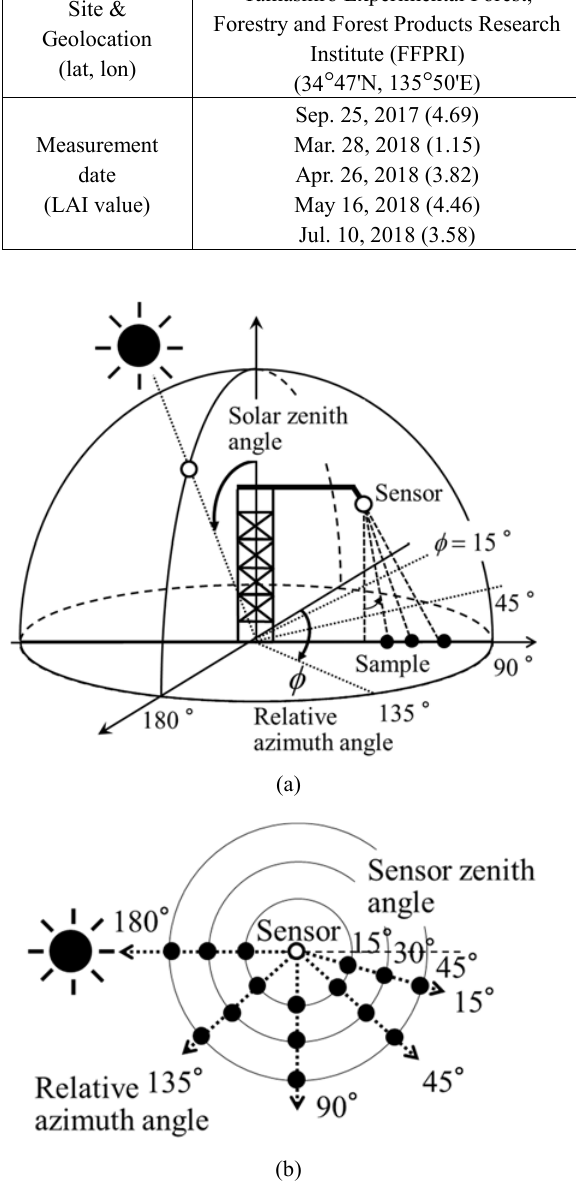
Figure 5. Measurement of BRF at the top of a tower in a forest (a) from an oblique viewpoint and (b) at the nadir